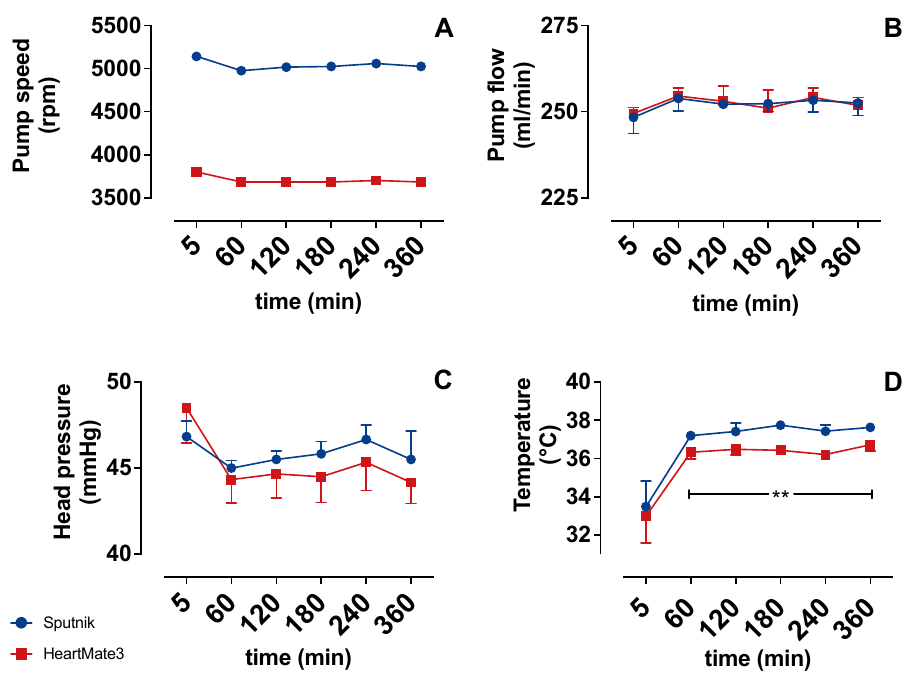
Figure 3. ( A ) Pump speed (rpm), ( B ) pump flow, ( C ) head pressure and ( D ) temperature over time. Significance: ** p < 0.01.